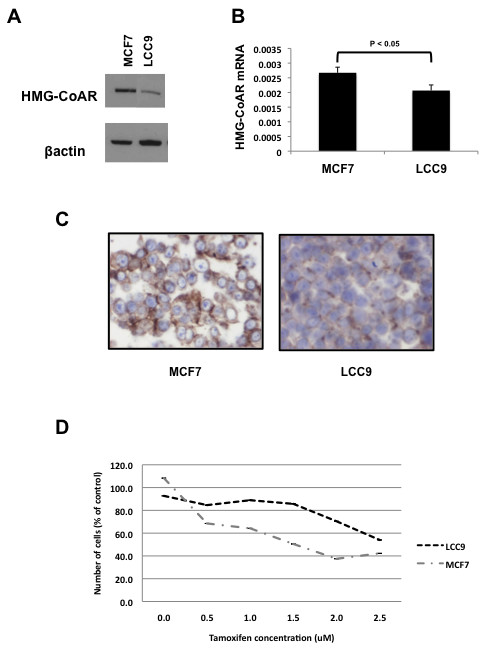
HMG-CoAR expression is associated with tamoxifen response in vitro. (a) Western blot demonstrating increased expression of 3-hydroxy-3-methylglutharyl-coenzyme A reductase (HMG-CoAR) in tamoxifen-sensitive MCF7 cells compared with their tamoxifen-resistant derivatives LCC9. (b) Quantitative reverse transcriptase PCR demonstrating increased expression of HMG-CoAR mRNA in MCF7 cells compared with LCC9 cells. (c) Immunohistochemistry demonstrating increased HMG-CoAR protein expression in MCF7 cells compared with LCC9 cells. (d) MTT assay demonstrating improved tamoxifen response in MCF7 cells compared with LCC9 cells.